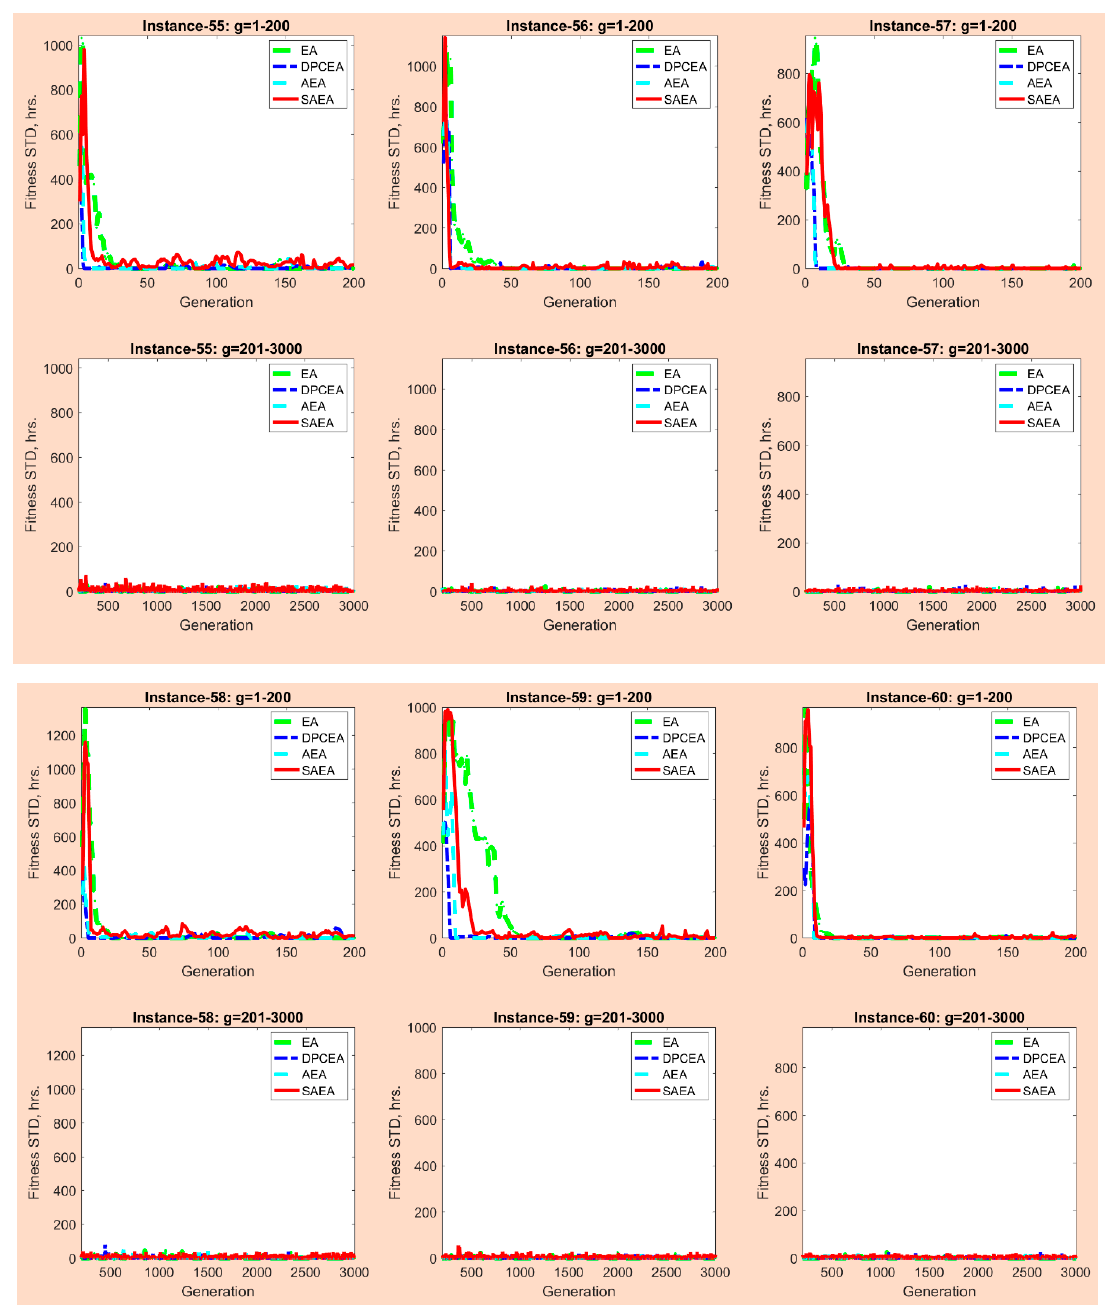
Figure 14. The population fitness STD values for the developed solution algorithms and problem instances 55–60.